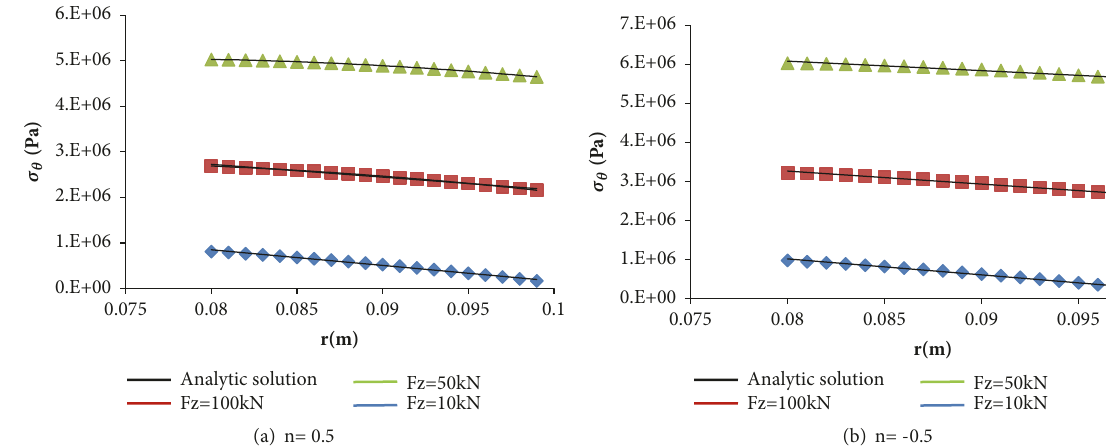
Fz=10kNFz=50kN Fz=100kNAnalytic